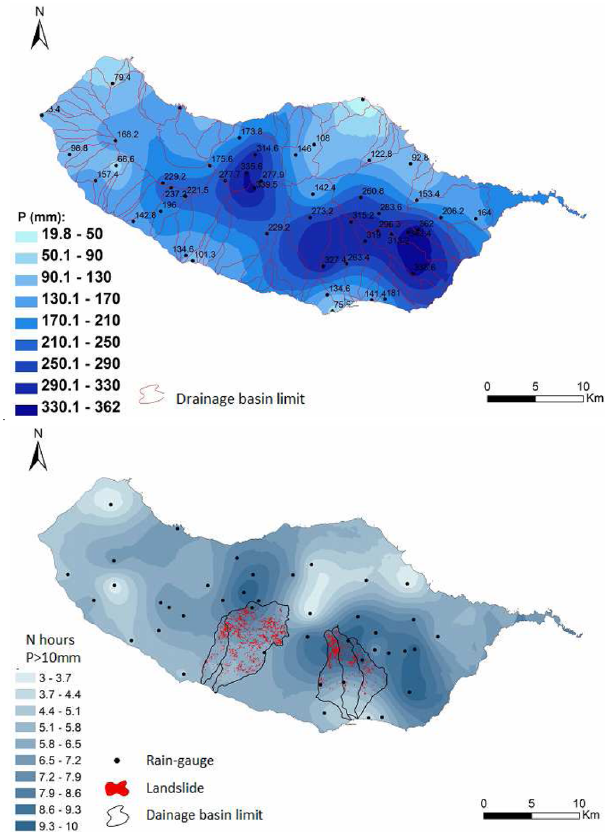
Fig. 5. (a) Total daily precipitation in Madeira (00:00–24:00UTC), 20 February 2010. The map is based on data from the same rain- gauge network represented in Fig. 1 (station names are listed in Ta- ble 1). (b) Number of hours with precipitation above 10mm and landslides distribution on Funchal and Ribeira Brava areas. This map is based on a subset of the network presented in Fig. 1, consist- ing only in udographic stations. Source: SRES,